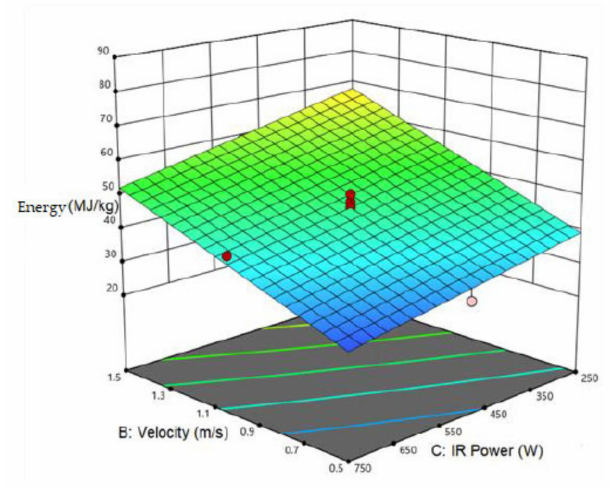
Figure 2. Interaction of air temperature/air velocity, air temperature/IR power, and IR power/air velocity on energy consumption of pumpkin.